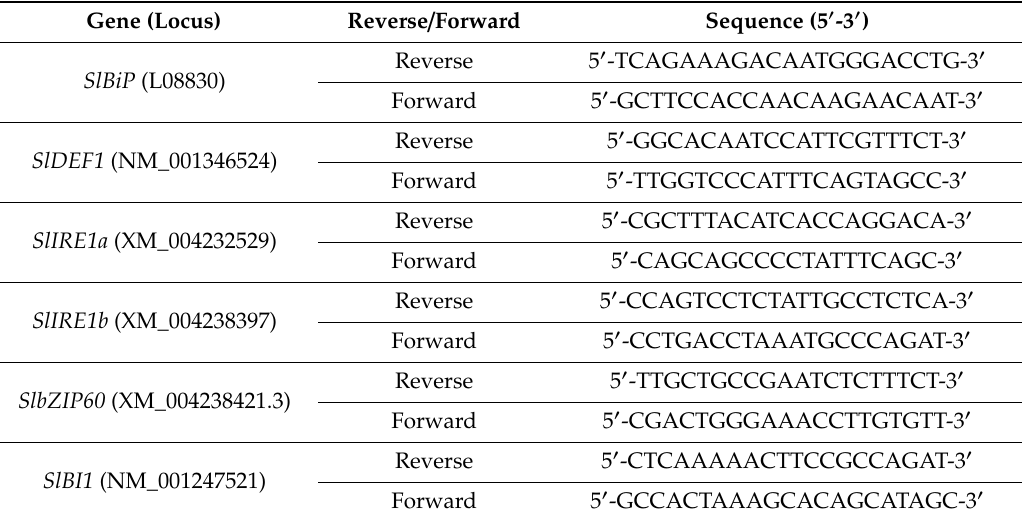
Table 1. Primer pairs used for